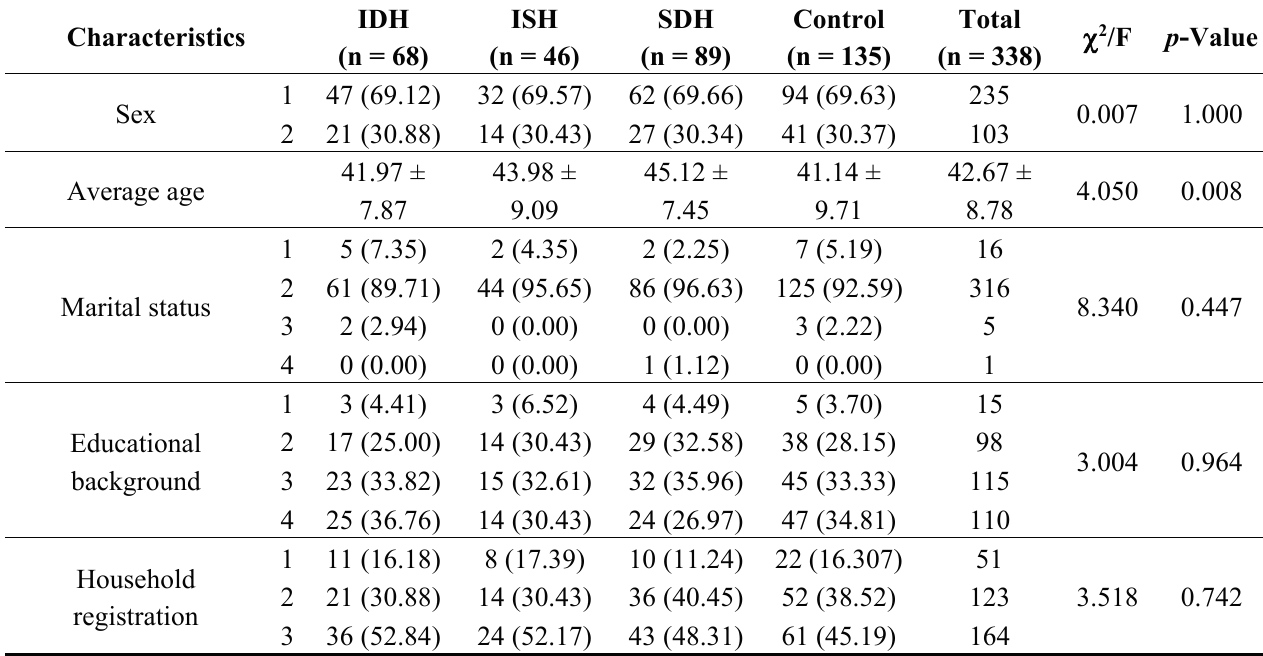
Table 1. The demographic characteristic of subjects